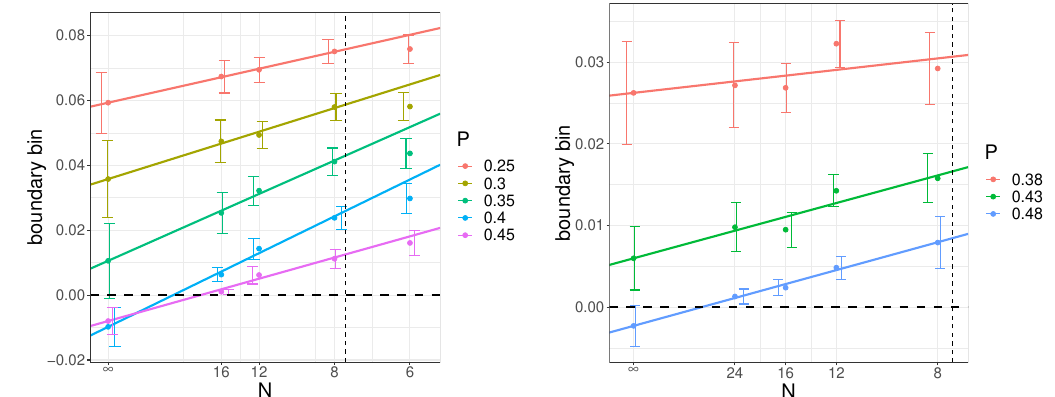
Figure 22. Full BMN, the histogram of the Polyakov line phases for [ P − ∆ P, P + ∆ P ] , where ∆ P = 0 . 02 , [Left] µ = 1 . 5 , N = 24 , L = 24 , T = 0 . 429 (close to T L = 24 , T = 0 . 45 (close to T c ) along with the large µ behavior ρ ( θ ) = 1+2 P cos θ deviation is observed close to P = 0 . 5 . The Myers term was constrained in the simulation for µ = 1 . 5 .